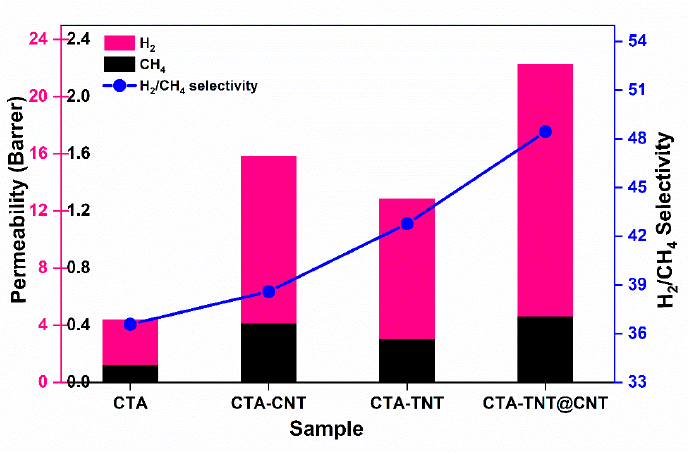
Figure 11. Single gas H 2 and CH 4 permeability and selectivity plot of the synthesized membranes.